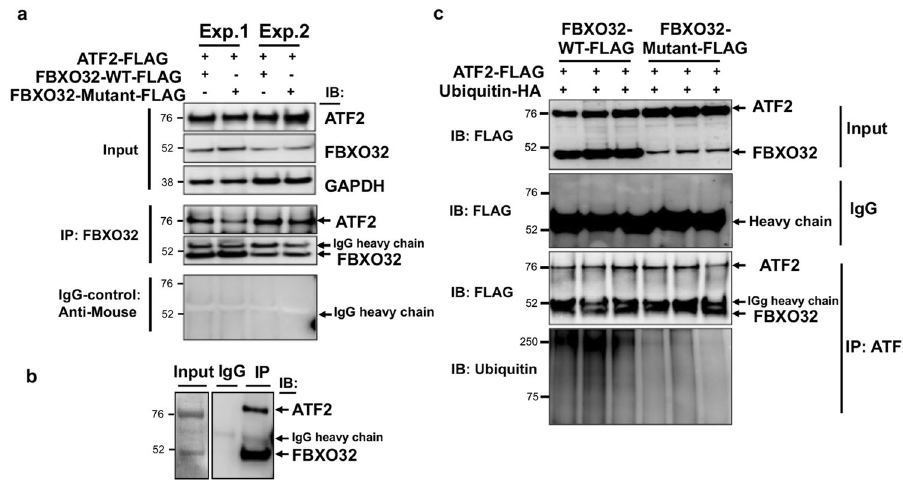
Fig. 5 FBXO32 interacts and targets ATF2 for ubiquitination. a FBXO32 interacts with ATF2 in HEK293 cells. Immunoprecipitation performed with FBXO32 antibody or control IgG antibody from HEK293 cells transfected with the indicated plasmids followed by immunoblotting using the indicated antibodies. The results are from two independent experiments. b Immunoprecipitation from a human heart showing interaction of ATF2 with FBXO32. IgG- Mouse antibody was used as control. c Representative immunoblots showing that FBXO32 regulates ATF2 ubiquitination in HEK293 cells. FLAG-tagged ATF2 was co-transfected with HA-tagged ubiquitin (HA-Ub) and WT-FBXO32 or mutant-FBXO32 in HEK293 cells. Cell lysates were immunoprecipitated with anti-ATF2 antibody and immunoblotted with the indicated antibody. Data are representative of 3 independent transfections for WT-FBXO32 and mutant-FBXO32 ( n = 2 – 3 replicates).